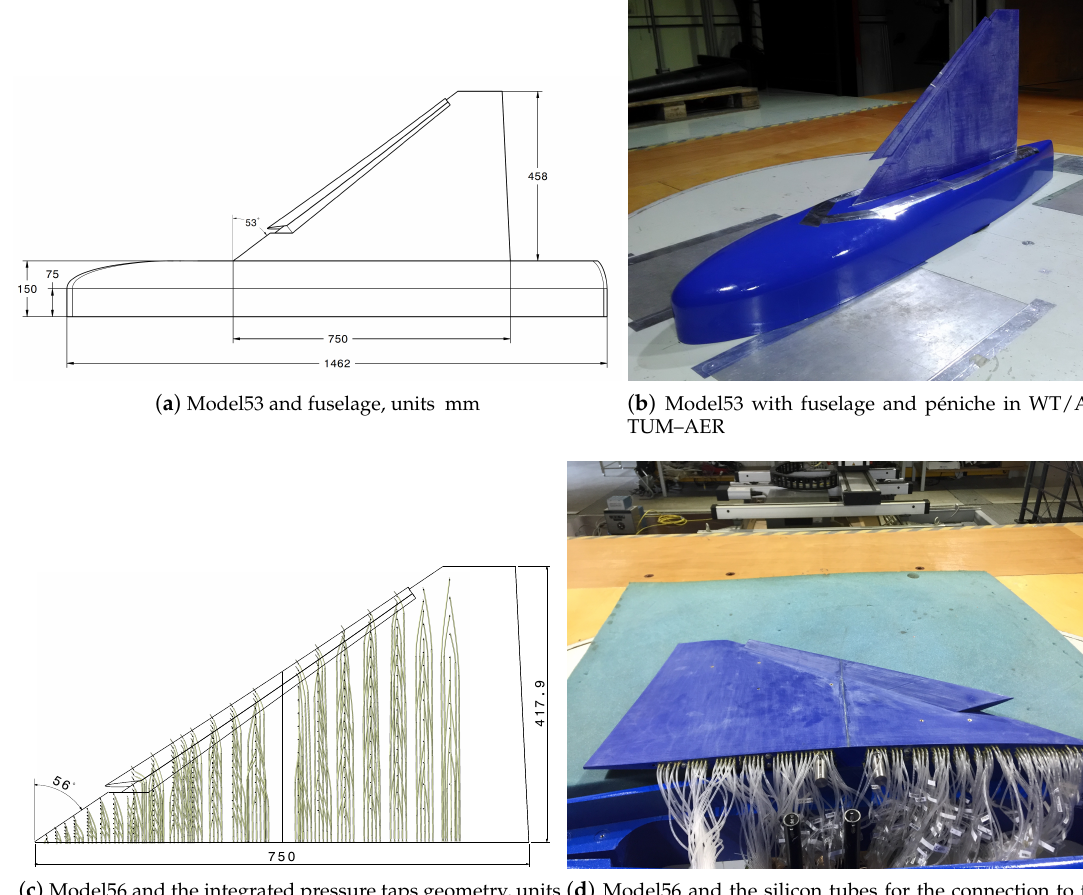
Figure 1. Model53 and Model56 wind tunnel